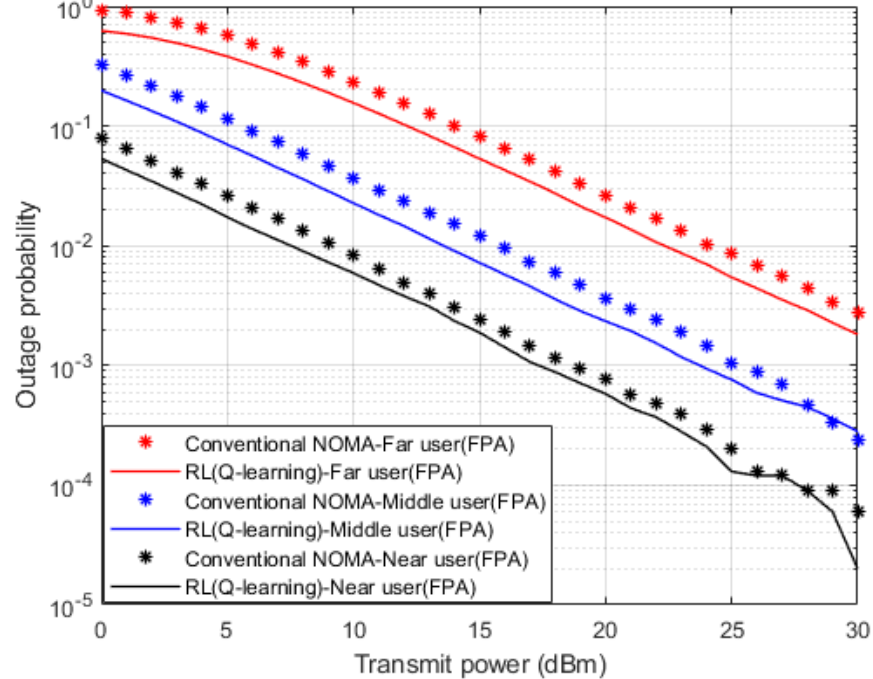
Figure 5. Outage Prob. vs. power ( Q -learning & Conventional NOMA